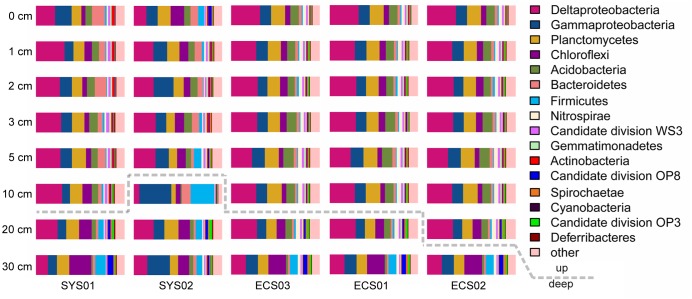
Relative abundance of dominant phyla (Deltaproteobacteria and Gammaproteobacteria) in different sediment samples. Dotted line divided the two groups defined by the Bray–Curtis similarity analysis at the genus level shown in Supplementary Figure S1.